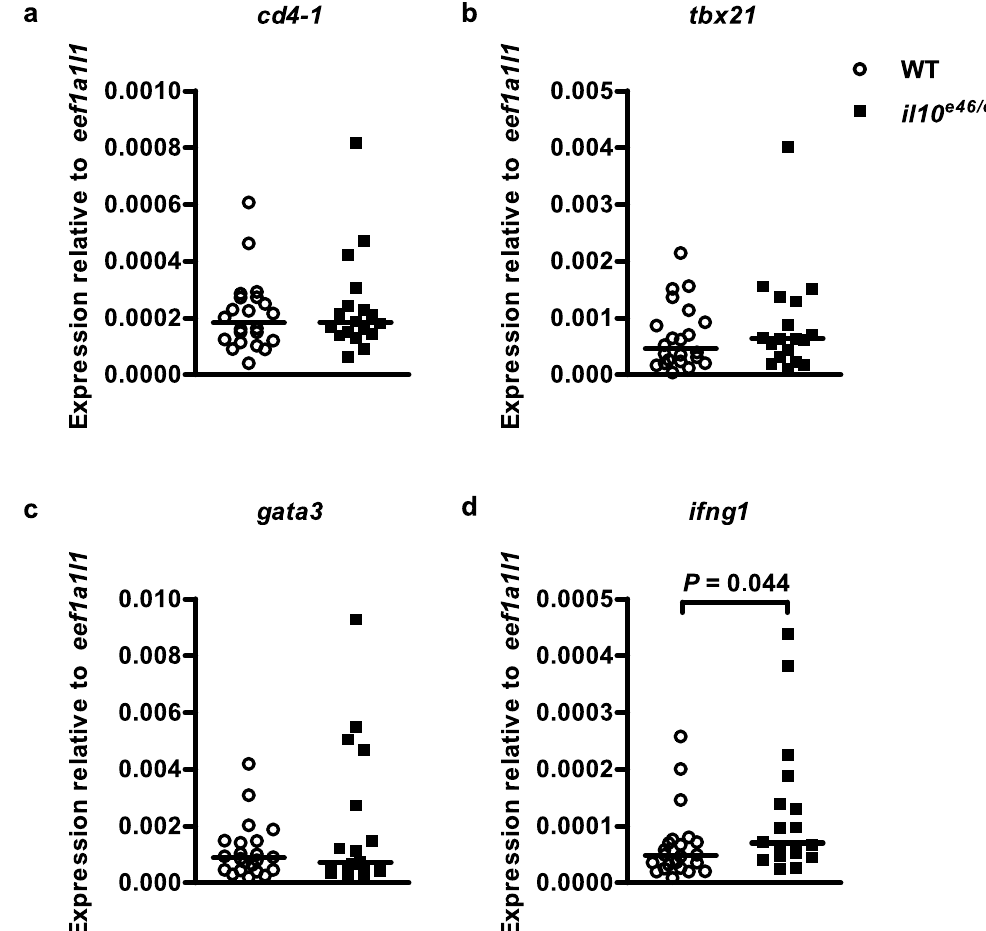
Figure 9. il10 e46/e46 mutant progeny of il10 e46/ + zebrafish have an elevated ifng1 expression level in a M. marinum infection. ( a – d ) il10 e46/e46 mutants were outcrossed to wild type AB zebrafish and their heterozygous progeny was incrossed. The ungenotyped offspring of il10 e46/ + fish was infected with a low-dose (8–17 CFU) of M. marinum . The relative expression of lymphocyte marker ( cd4-1 ), Cd4 + lymphocyte transcription factors ( tbx21 , gata3 ) and Th1 cytokine ( ifng1 ) was measured in the kidneys of il10 e46/e46 ( n = 18) and WT ( n = 22) zebrafish at 8 wpi. Note the different scales of the y axes. Gene expressions were normalized to the expression of eef1a1l1 . The data were collected from a single experiment. A two-tailed Mann-Whitney was used for the statistical comparison of